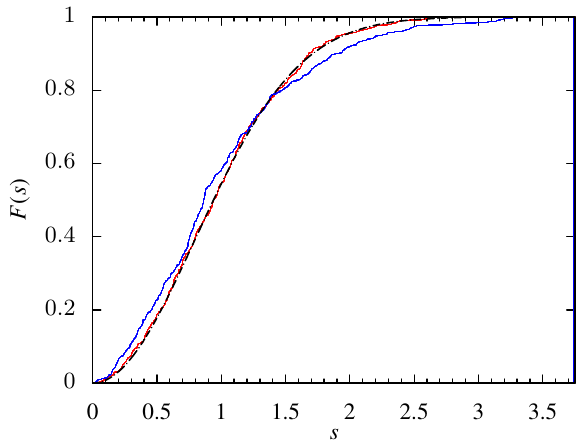
Figure 1: Left: RC made chaotic through the introduc- tion of 3 half-spheres. Right: Conventional RC. The small squares correspond to Ohmic absorptive patches. For both cavities, the dimensions are: L x = 2 . 951 m, L y = 2 . 751 m, L z = 2 . 354 m.